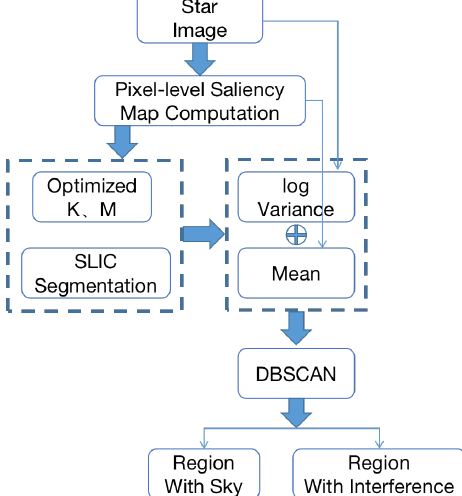
Figure 5. Flowchart of the proposed method.